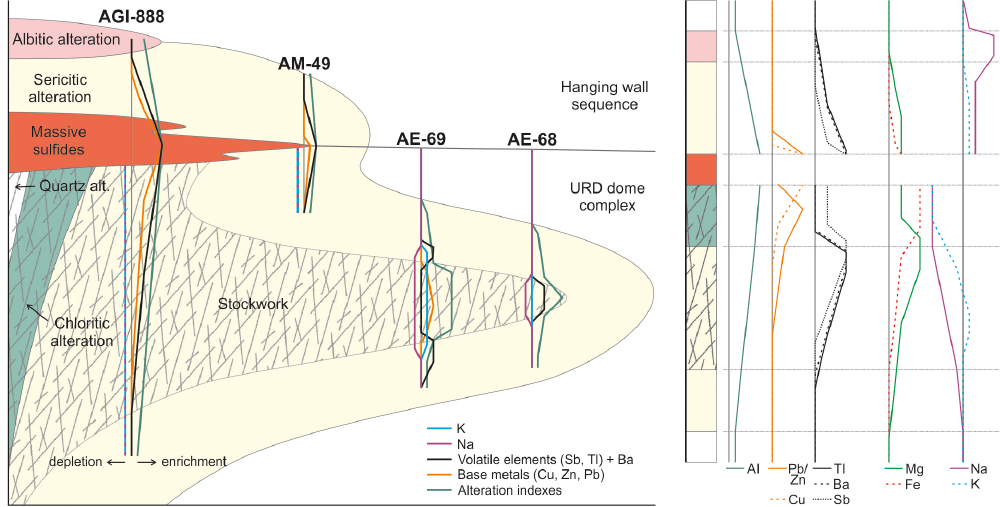
Figure 16. Schematic summary of the main observations performed in this study on vectoring tools related to hydrothermal alteration mineral zoning and whole rock geochemistry of major and trace elements. Sodium enrichment in the albite alteration zone is inferred and needs to be confirmed. Not to scale. AI: alteration indexes (AI, CCPI; alt. –